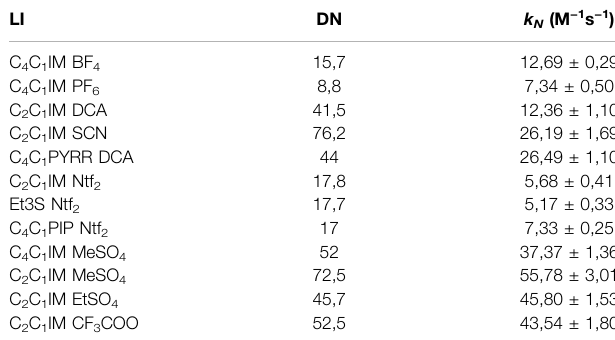
TABLE 6 | Donor number and nucleophilic rate constant for the reaction between 2-chloro-5-nitropirimidine and morpholine in different ILs.